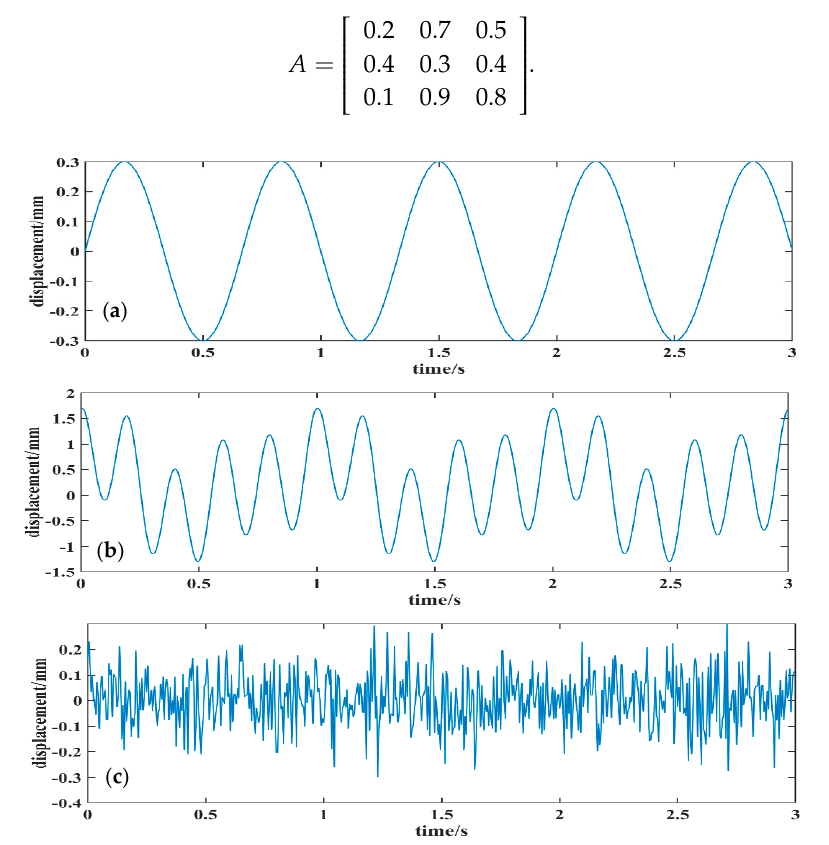
( ) S t , ( b ) the curve of signal 1